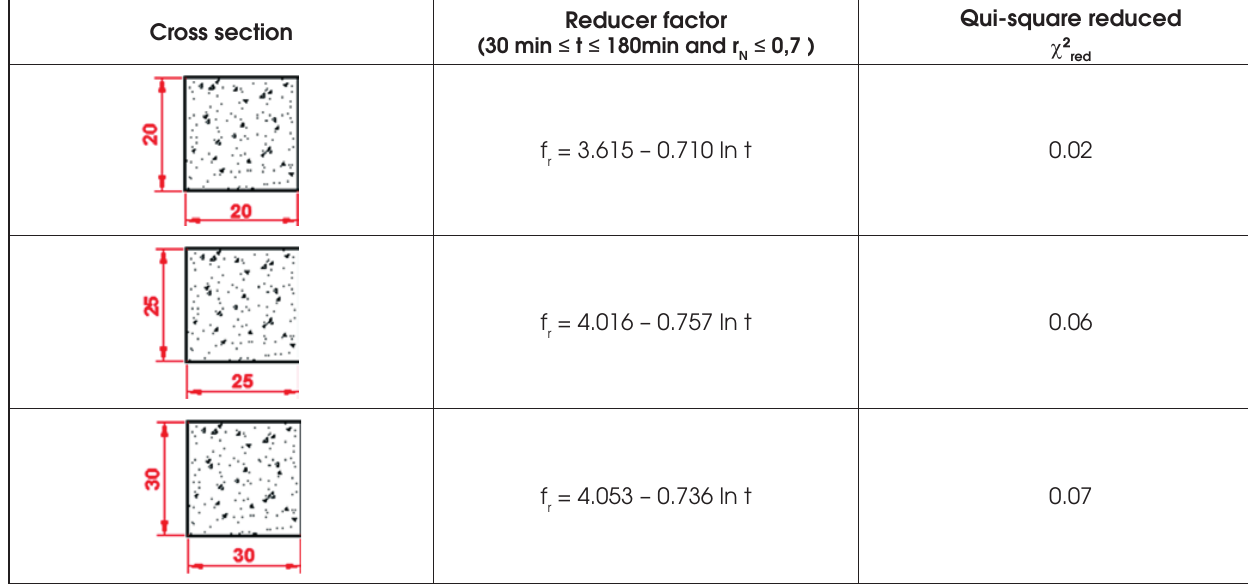
Results to factor ‘f